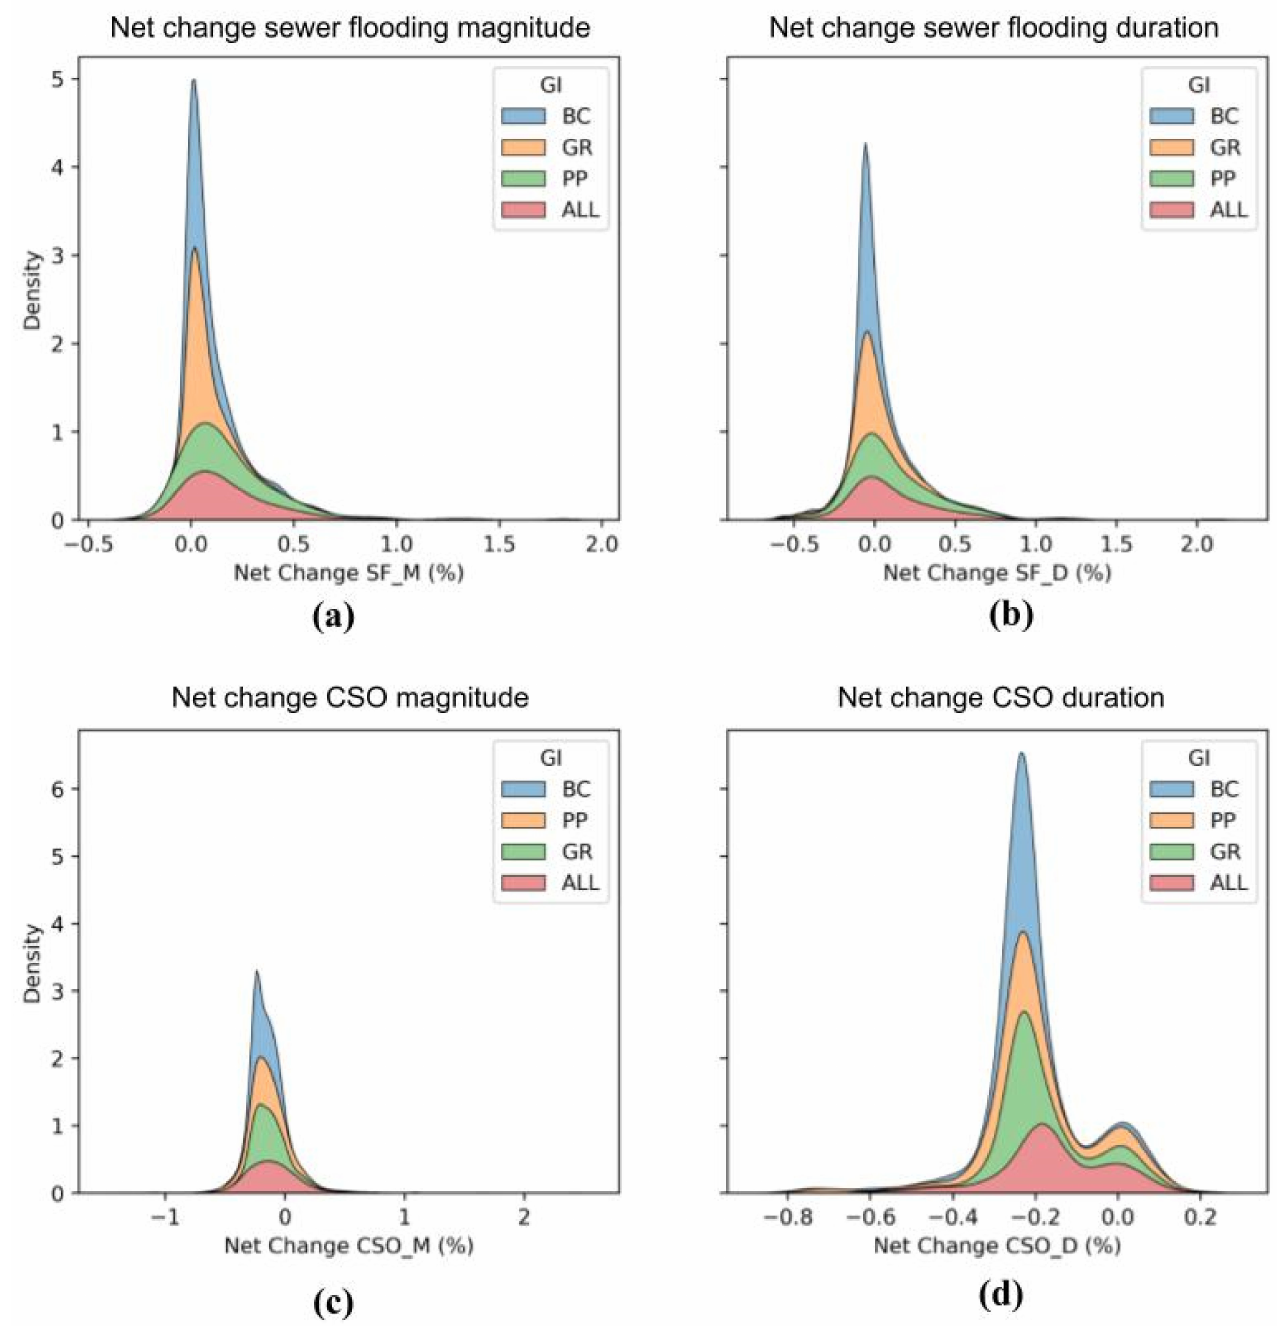
Figure 5. Kernel density estimation plots of the results from the location sensitivity analysis. BC: bioretention cell. PP: Permeable pavement. GR: Green roof. ALL: all the GI simultaneously in the subcatchment at maximum spatial extent. ( a ) Net change in sewer flood magnitude. SF_M: sewer flood magnitude. ( b ) Net change in sewer flood duration. SF_D: sewer flood duration. ( c ) Net change in CSO magnitude. CSO_M: combined sewer overflow magnitude. ( d ) Net change in sewer flood duration. CSO_D: combined sewer overflow